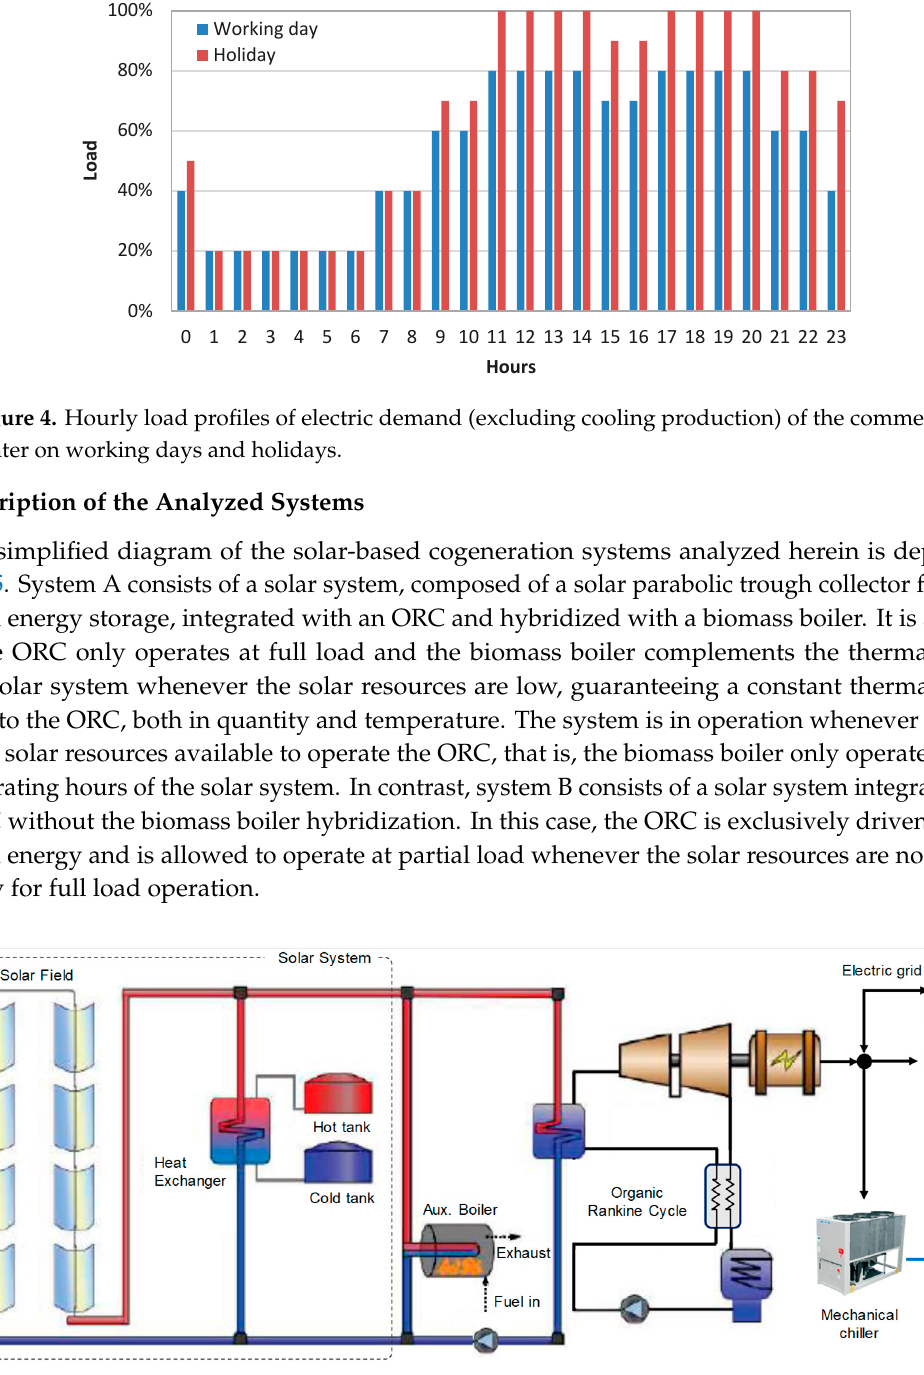
Figure 3. Hourly thermal cooling demands (kWh t ) of the commercial center throughout the year: ( a ) working days; ( b ) holidays.